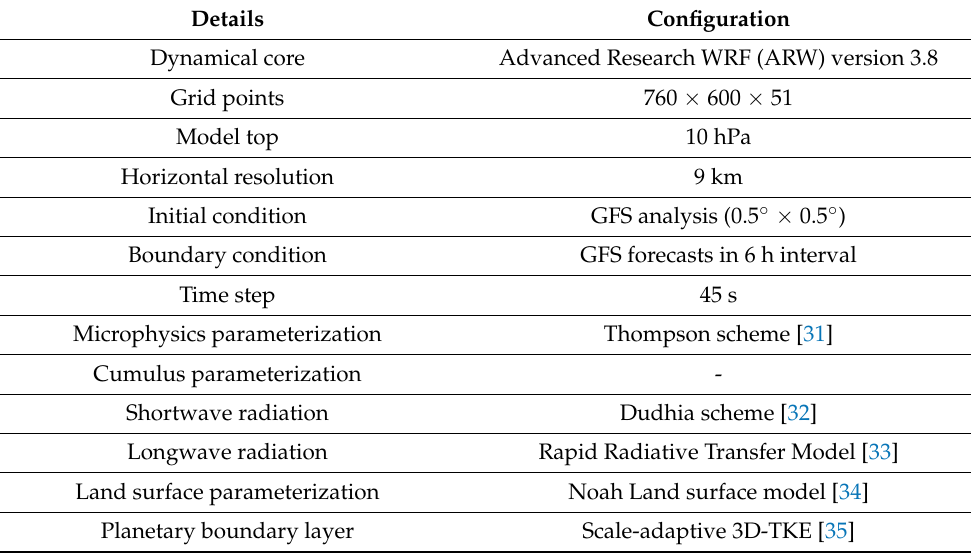
Table 1. Details of the WRF model configurations.